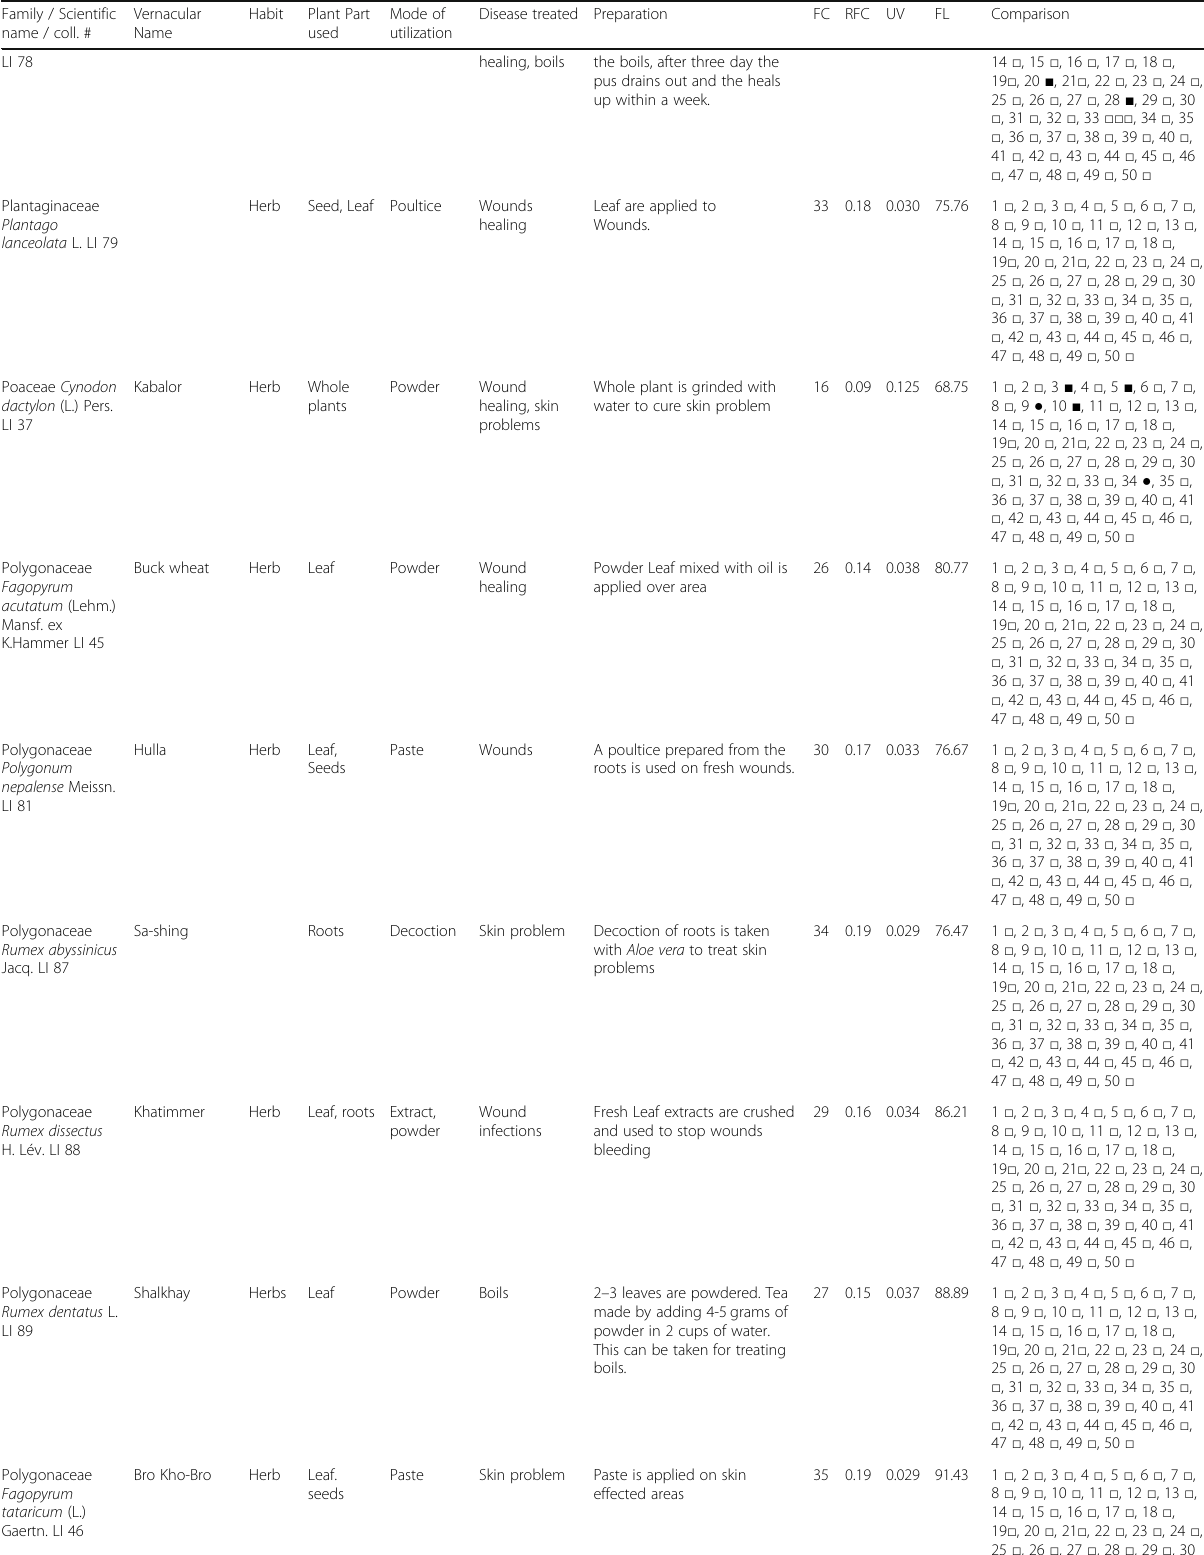
Table 2 Medicinal plants used for skin diseases in Northern Pakistan (Continued) Family / Scientific name / coll.